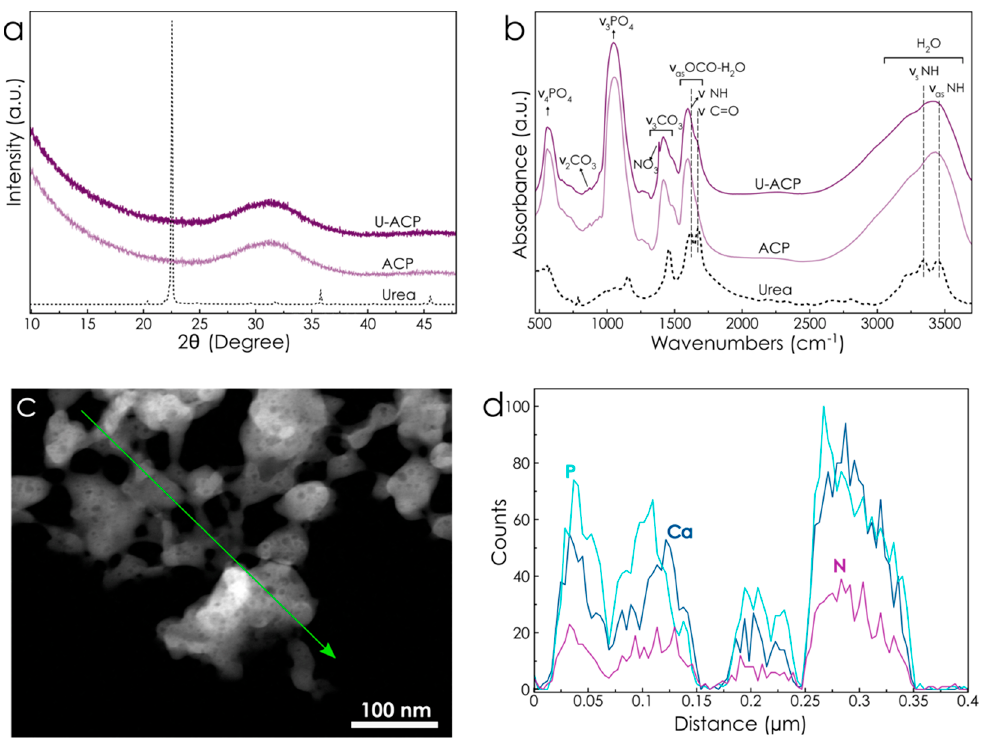
Figure 2. Structural and compositional characterization of U-ACP. XRD patterns ( a ) and FTIR spectra ( b ) of crystalline urea (dotted line), non-doped ACP nanoparticles and U-ACP nanocomposite. High-angle annular dark-field (HAADF) image ( c ) and line profile energy-dispersive X-ray spectroscopy (EDS) of U-ACP nanoparticles showing the Ca K α (dark blue curve), P K α (light blue), and N K α (magenta) signals ( d ).